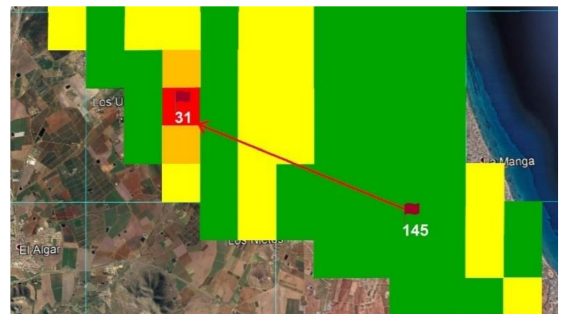
Figure 10. Map zone selected for the simulation with starting point at Box 145 and finishing point at Box 31.